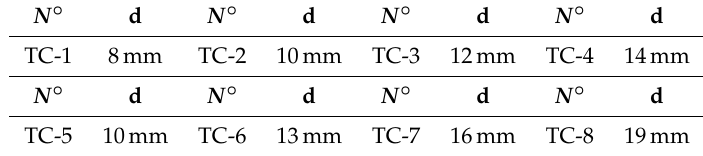
Figure 11. Real specimen’s geometry ( left ), simplified specimen’s geometry ( right ). Table 3. Thermocouples’ distance from the welding seam: d = distance, N ◦ = thermocouple’s number. N ◦ d N